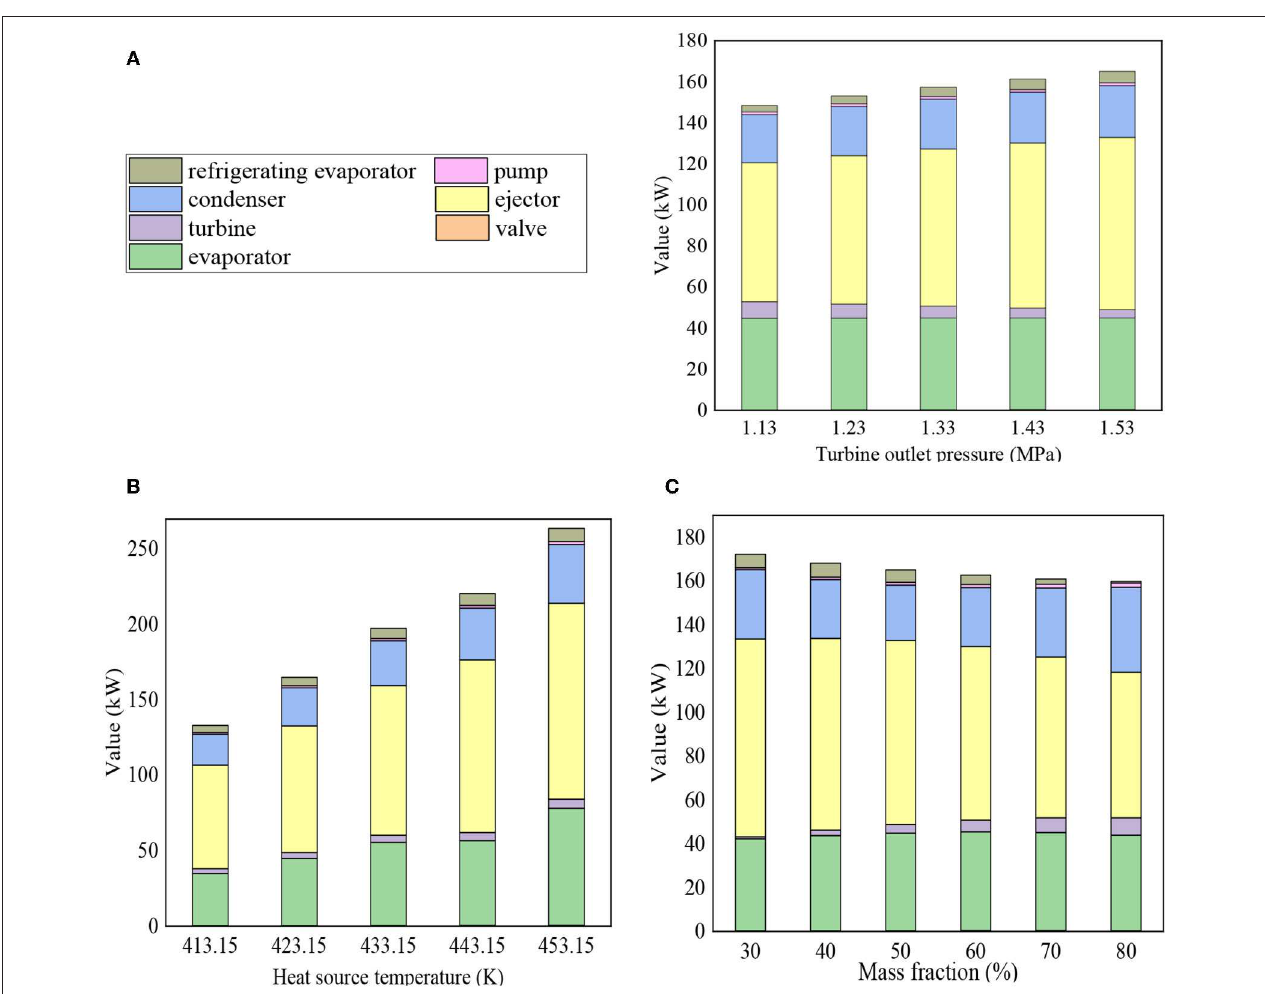
FIGURE 8 | Distribution of components destruction of. (A) Turbine outlet pressure; (B) heat source temperature; (C) mass fraction.